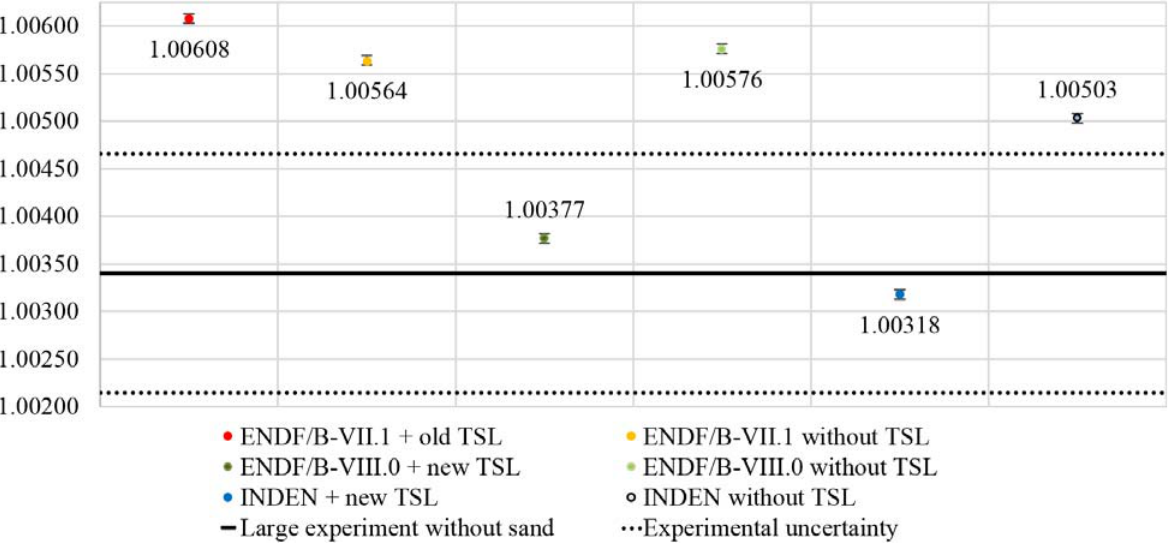
Figure 4. Multiplication factor for large experiment with silicon in different nuclear data libraries.